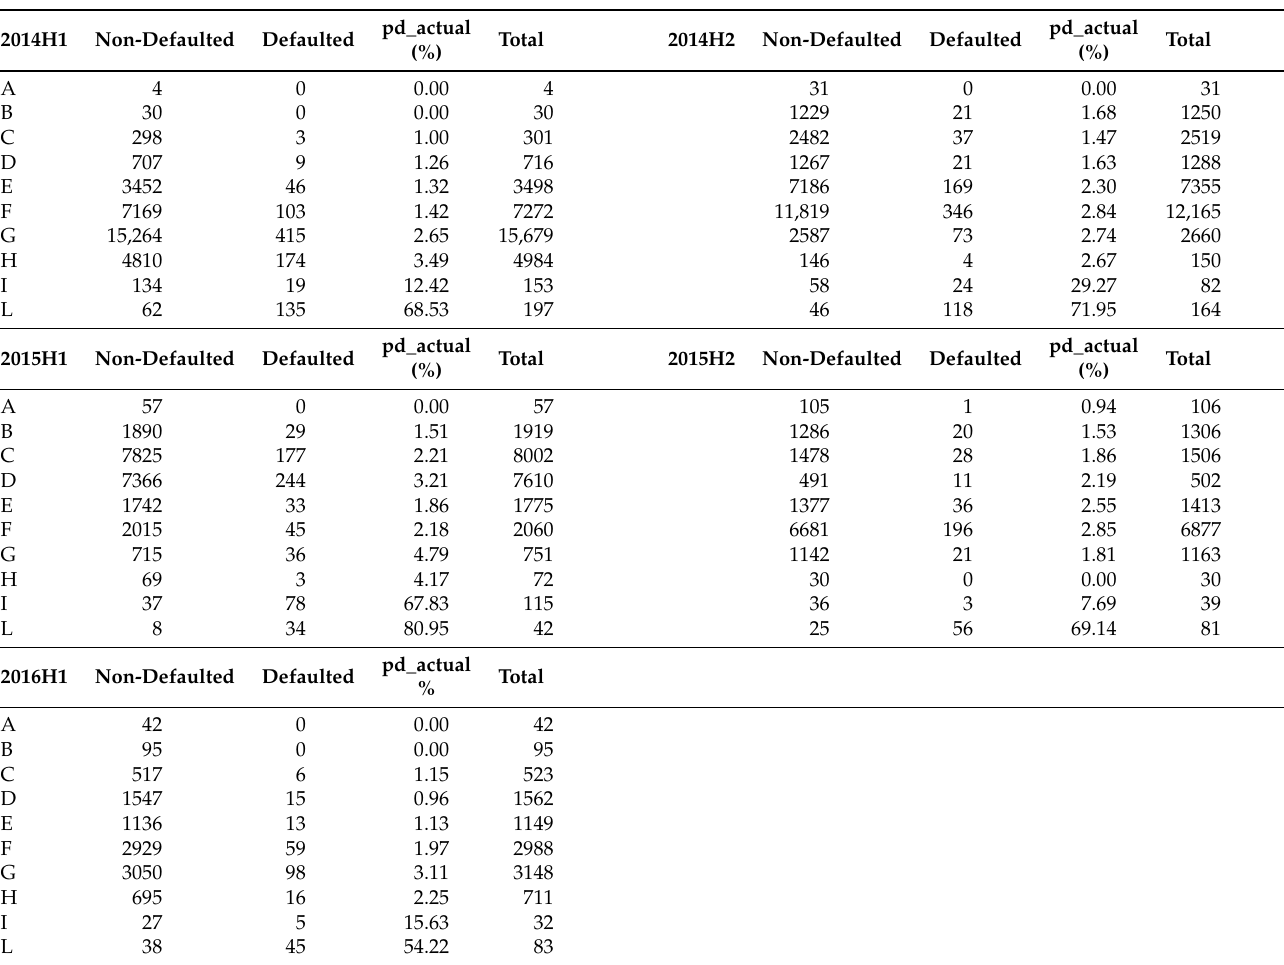
Table A2. The table shows rating (column 1), amount of non-defaulted loans (column 2), amount of defaulted (column 3), default frequency (column 4) and total number of loans included in the sample per rating class (column 5). We report the statistics for the different pool cut-off